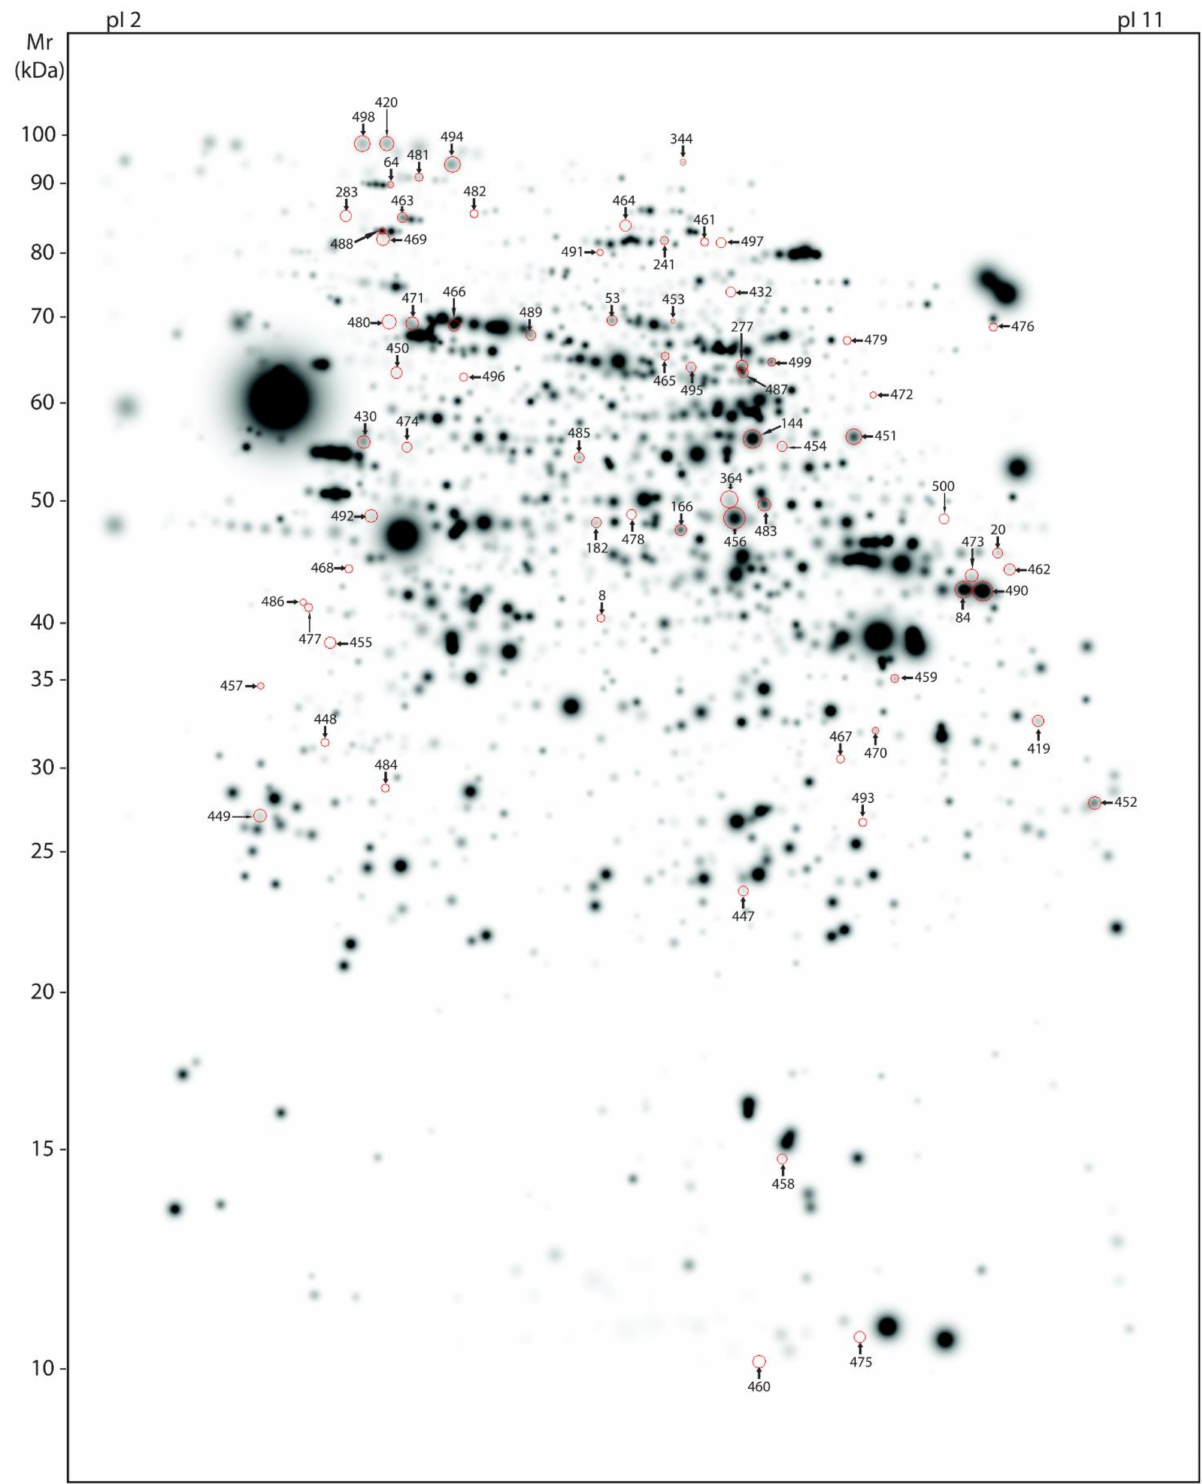
Figure 2. Master gel representing protein spots differentially abundant between genotypes. Average, large-scale 2-DE gel pattern of brain proteins extracted with urea and stained with silver. All 71 protein spots varying between the genotypes (wild-type and L66) were identified by MS and are highlighted by arrows in representative wild-type gel (artificial gel image created by the Proteomweaver software that shows average spot intensities of the wild-type mouse cohort). Identification numbers (spot IDs) correspond to numbering as provided in the Supplementary Table